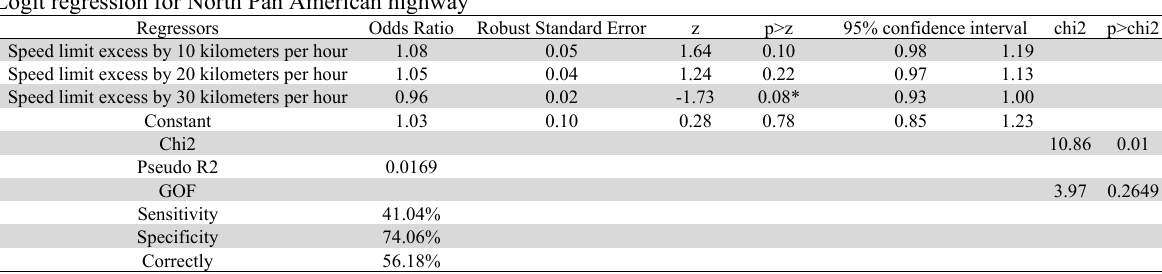
Logit regression for North Pan American